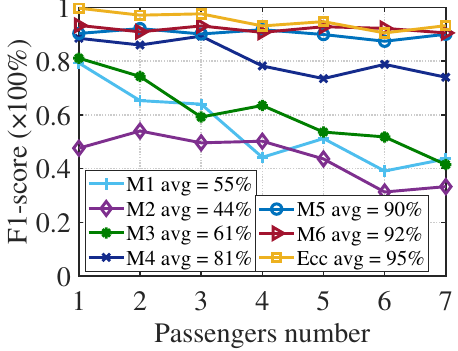
Figure 17. Comparison with different methods.